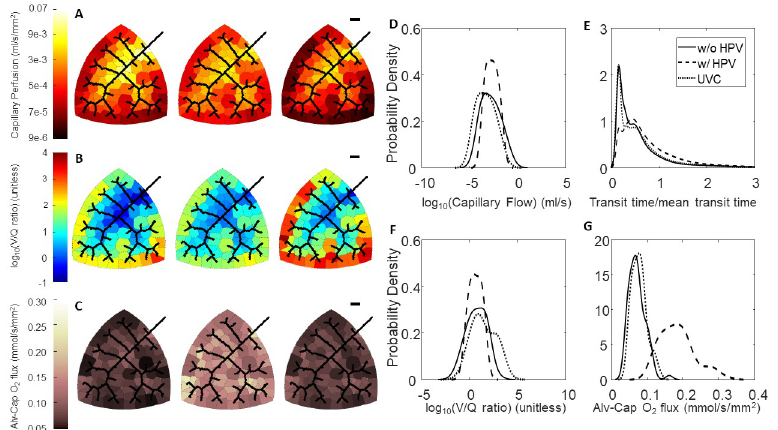
Fig 6. Effect of HPV and uniform vasoconstriction on Network A regional perfusion, V/Q matching, and oxygen flux. (A-C) Leftmost column of networks are without regulation from HPV, middle column of networks are with regulation from HPV, and the rightmost column of networks are with uniform vasoconstriction, where T � = 0.8 is used for the global vascular tone. The black scale bar is 1000 μ m. (A) Perfusion in the capillary compartments; (B) Ventilation-perfusion (V/Q) ratios in the capillary compartments; (C) Oxygen flux in the capillary compartments. (D-G) Blood flow, RBC transit times, V/Q ratios, and oxygen flux expressed as probability densities—calculated with a kernel density estimator. (D) Distribution of flow; (E) RBC transit times normalized to mean transit time; (F) Distribution of V/Q ratios; (G) Distribution of oxygen flux.